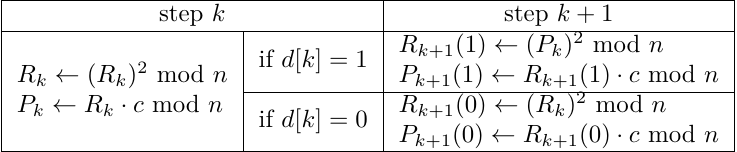
Table 1: The input to the operations computed in step k + 1 depending on d [ k